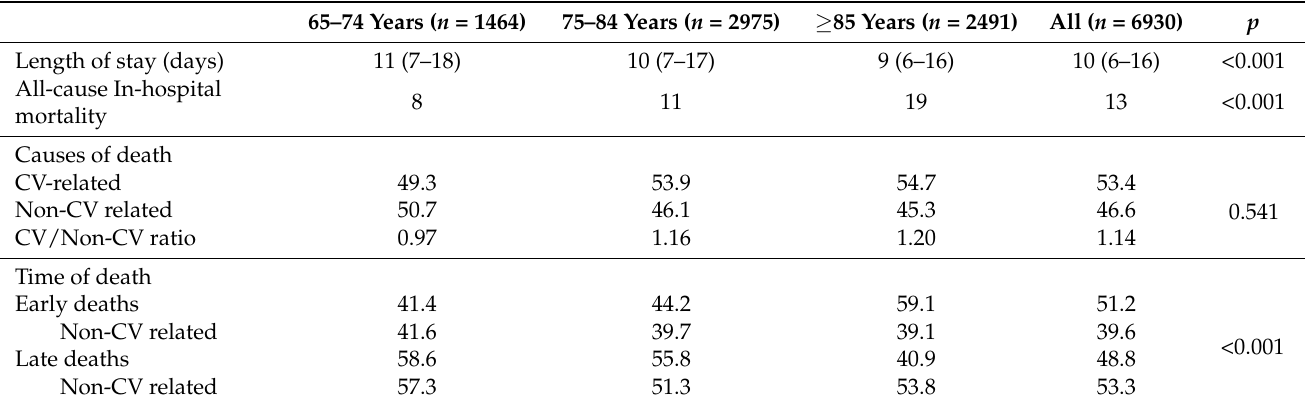
Table 3. In-hospital length of stay and